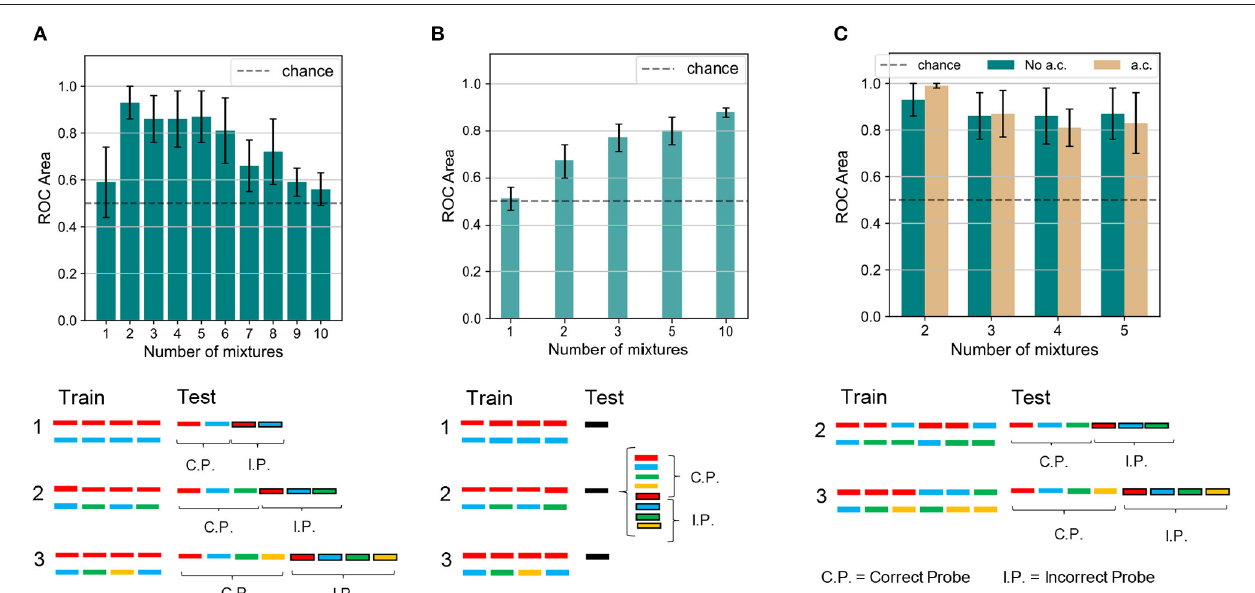
FIGURE 5 | Experiment 1 and 1 a.c.—results and comparison with human performance. (A) Results and schematics for Experiment 1 on the dendritic network model. The number of mixtures is varied from 1 to 10. Performance is close to chance for a single training mixture. The performance is boosted as two mixtures are presented. As the number of mixtures is further increased, the clustering accuracy slowly decreases toward chance values. The protocol shown at the bottom of the panel illustrates that (i) in the training phase we feed the network only with the mixture(s), i.e., target+masker sound(s). (ii) in the inference phase we feed the network only with the unmixed sounds (target, distractor separately) and with the incorrect probes (also unmixed sounds). We remark that in the case of one mixture (condition 1) the target and the masker sounds play the same role, while in the case of multiple mixtures (conditions 2 and 3) the target has a different role in the protocol as it is present in more than one mixture while the masker sounds are presented in one mixture only in the training sequence. (B) Results and schematics for Experiment 1 on the human experiment. The number of mixtures presented are 1, 2, 3, 5, and 10. For a single mixture the performance is close to chance. As the number of mixtures increases, the classification accuracy improves steadily. Figure reproduced based on data acquired by McDermott et al. (2011). (C) Results and schematics for Experiment 1 a.c. on the dendritic network model. The number of mixtures is varied from 2 to 5. Combining all the mixing sounds in mixtures slightly improves the mean performance for two mixing sounds, while it slightly worsens it for a larger number of mixtures. The height of the bars and the error bars show, respectively, mean and standard deviation of the AUC over 10 independent